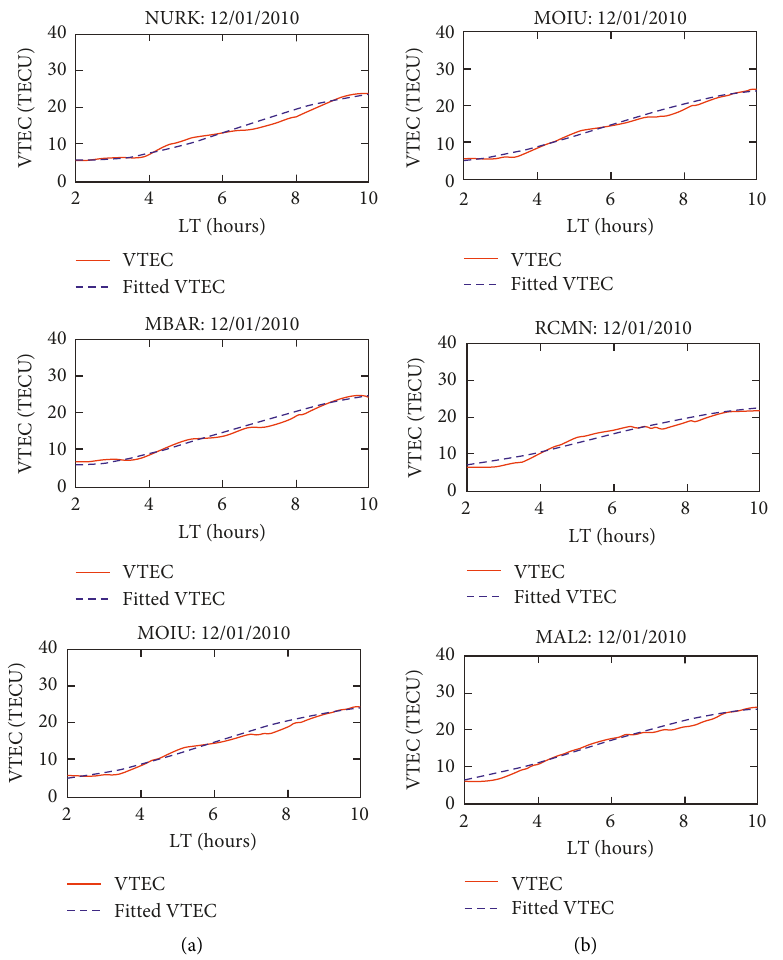
Figure 6: VTEC and fitted VTEC against local time (LT) across (a) NURK-MBAR-MOIU and (b) MOIU-RCMN-MAL2 GPS array on 12 th January